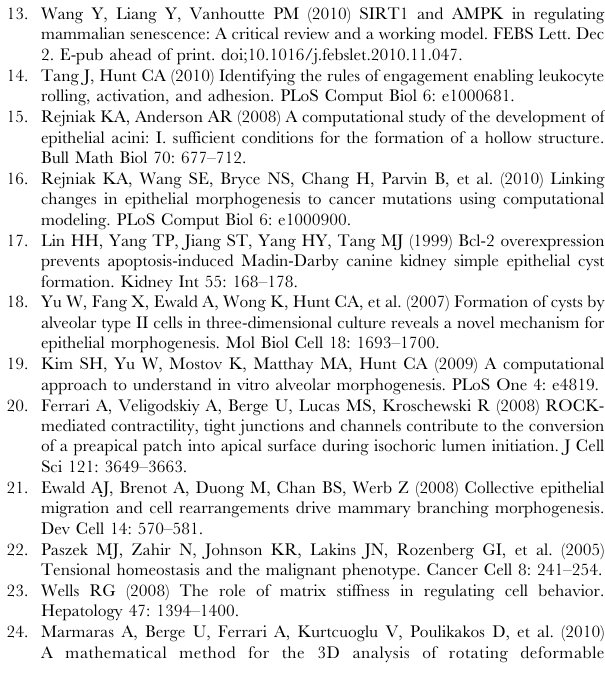
Table S3 Additional ISMA parameters. Parameters used for the ISMA system and for the adhesion plug-in are listed along with descriptions, default values used for simulation, and parameter ranges that are expected to give normal results.